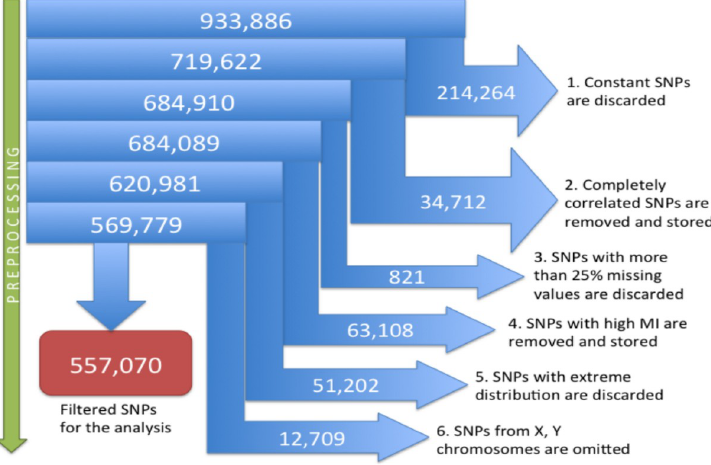
Fig 11. The preprocessing steps of the genotype data showing the number of SNPs removed from Delta analysis.